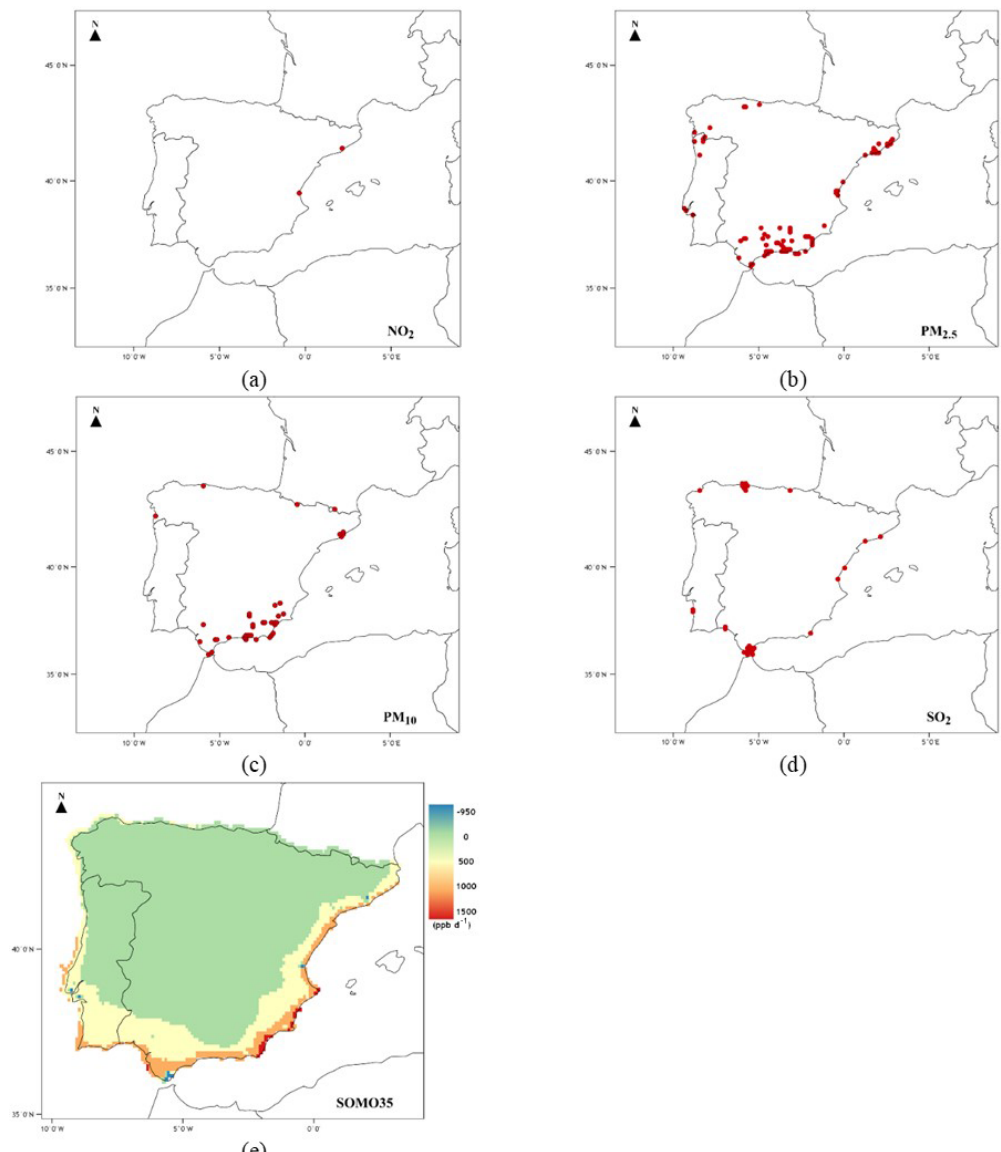
Figure 5. Spatial distribution of inland exceedances of EU air quality standards and WHO air quality guidelines (same value) for (a) NO 2 , (b) PM 2 . 5 , (c) PM 10 , (d) SO 2 , and (e) SOMO35 levels due to shipping emissions